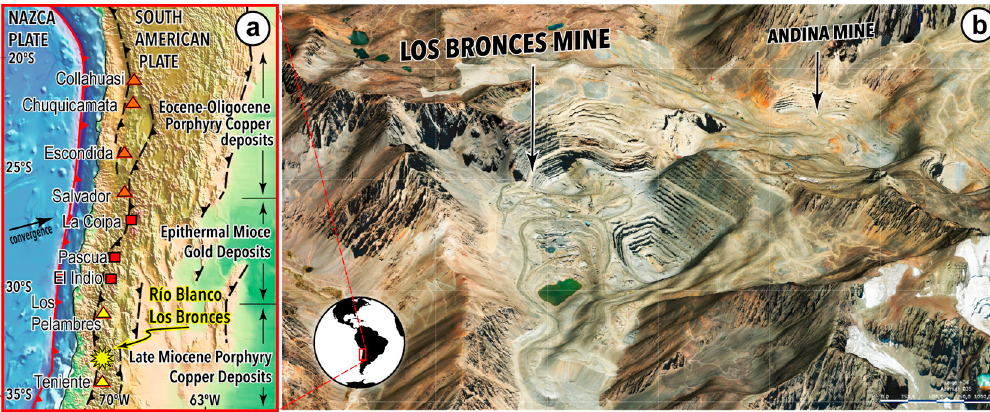
Figure 2. ( a ) The simplified tectonic map of South America showing the regional location of the Los Bronces-Rio Blanco District in relation to the metallogenic provinces of the Central Andes. ( b ) Leapfrog’s orthographic projection of the Rio Blanco-Los Bronces district, showing the location of the Los Bronces Mine and the Andina Mine (modified from Reference [28]).